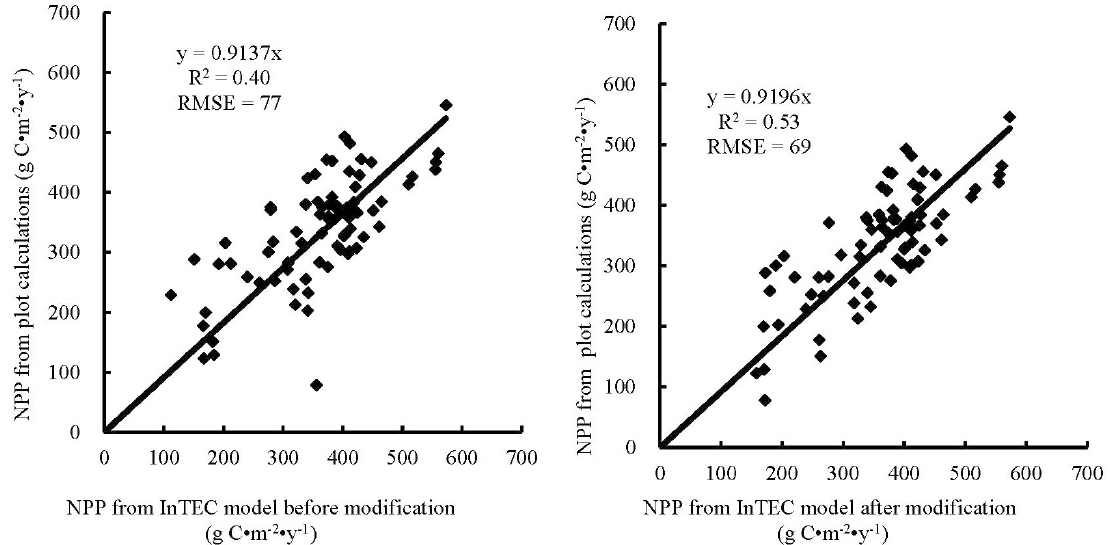
Figure 11. Estimations of NPP from the InTEC model before and after modification and from plot calculations.